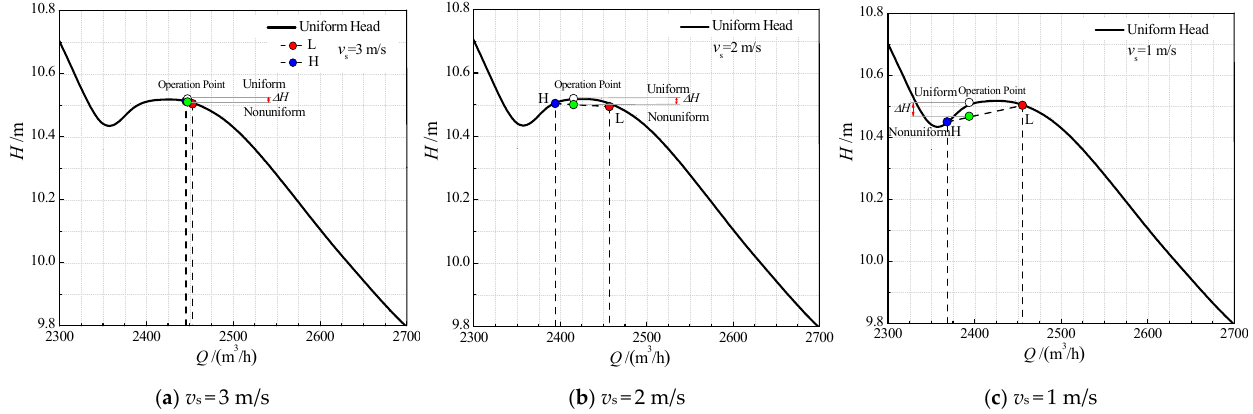
Figure 10. Operating point comparison between tube L and H, at pre-stall condition. Full stall occurs in the ship speed from of 1 m/s to 3 m/s: tube L maintains stall inception and tube H operates at stall condition. As depicted in the movement of blue point from Figure 11a–c, tube H climbs up to the hump at ship speed 3 m/s; as the ship speed continues reducing, tube H gradually moves down toward the valley where the flow rate is lower than 2450 m 3 /h; so, it is indicated that tube H operates at stall condition within this ship speed range. Additionally, tube L returns and rapidly climbs up to the hump again at ship speed 3 m/s, as evidenced by sharp flow rate drop; as the ship speed continues reducing, tube L fixes on the hump instead of moving down toward the valley as well as tube H; so, it is indicated that tube L maintains the invariant stall condition owing to the unchanged flow rate. As a consequence, tube L (invariant stall) united with tube H (evolving stall) results in a full stall behavior in the parallel system, i.e., waterjet pump under nonuniform inflow.